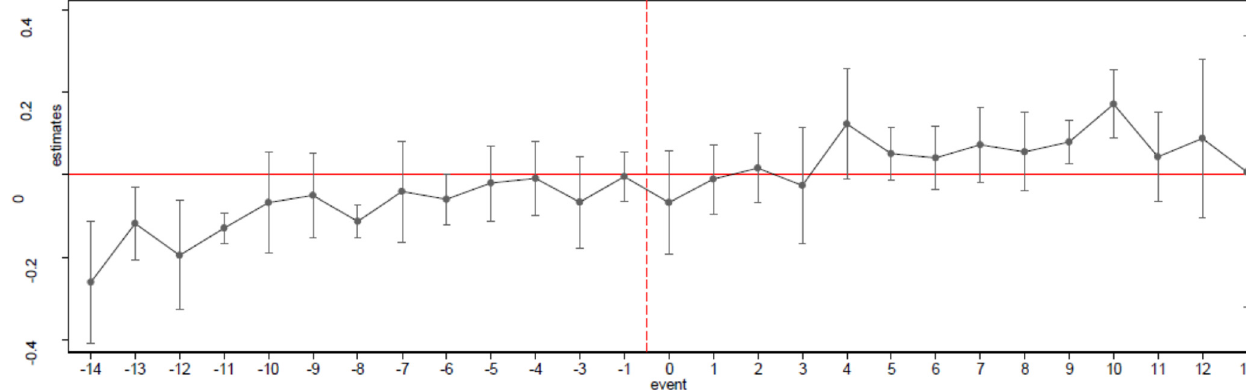
Figure 7. Parallel Trends Analysis—Event Studies on Loans Granted—Others Sector.